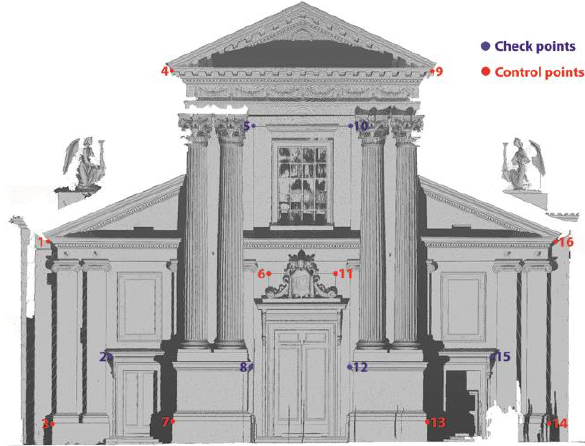
Figure 5. Point cloud from laser scanner with GCPs.